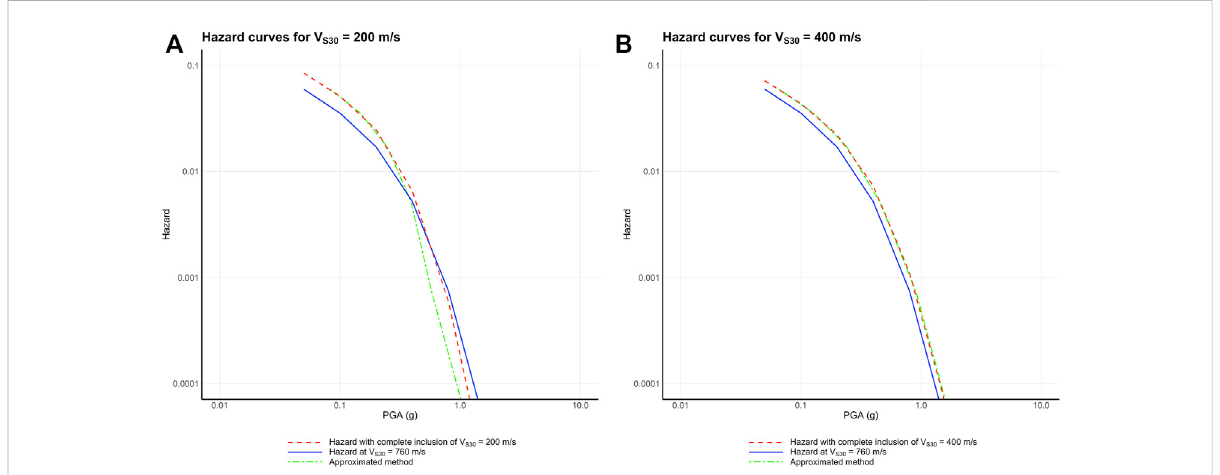
FIGURE 5 (A) Hazard curves for 760 m/s(blue lines) compared to those computed viathecompletemethodfor site-speci fi cV S30 of200 m/s(red dashed line) and approximate method (green dashed line). (B) Similar comparison for V s30 = 400 m/s. At V S30 = 400 m/s, the approximate and